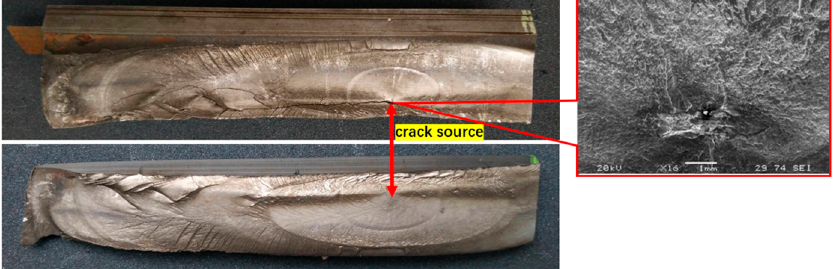
Figure 1. Tooth internal fracture fatigue failure.